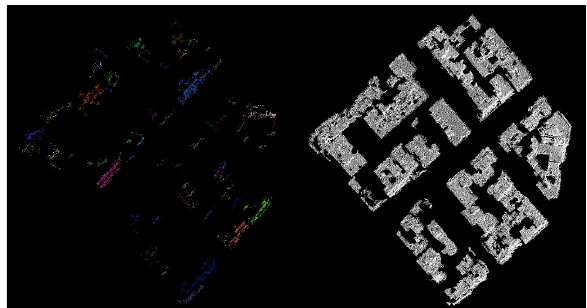
Figure 8. The detected edges (left) by DoN operator and the refined point cloud with normalized edges (right)